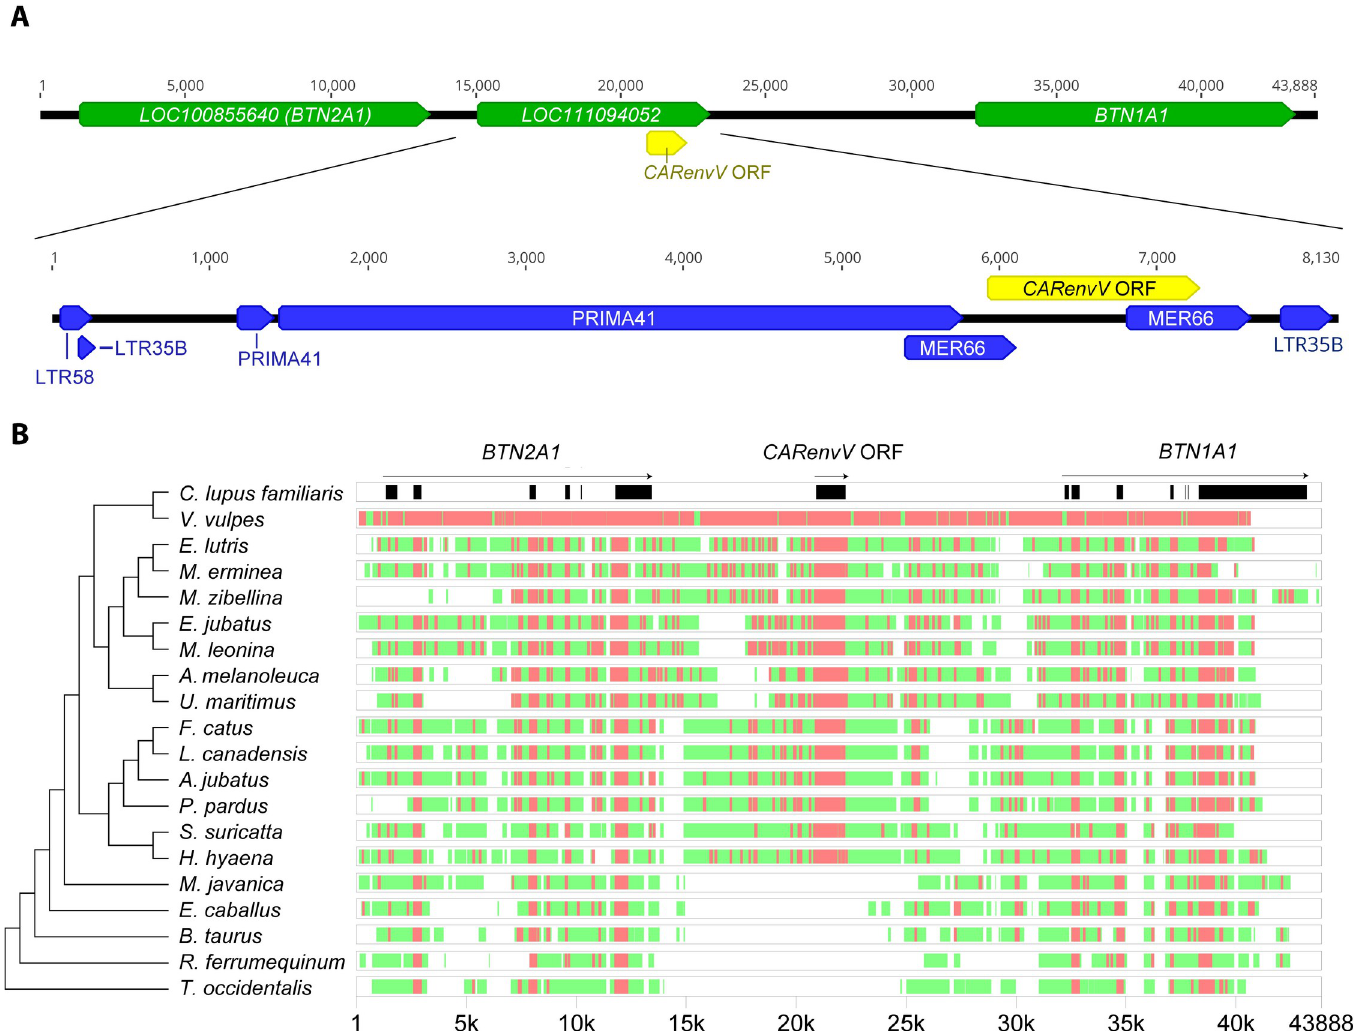
Fig 1. Genomic location and conserved synteny of CARenvV . A. (Upper panel) Chromosomal context of the CARenvV locus is shown for the C . lupus familiaris (domestic dog) genome (ROS_Cfam_1.0, chromosome 35). Refseq annotated genes are shown in green, and the CARenvV ORF is in yellow. (Lower panel) ERV derived repeat elements identified by the Dfam repeat database for the indicated region are annotated in blue. B. Genomic segments containing the CARenvV ORF and the BTN1A1 and BTN2A1 genes were extracted from the NCBI genome database for each of the indicated species and aligned using the MultiPipMaker alignment tool [108]. The CARenvV ORF and the BTN1A1 and BTN2A1 exons are shown in black boxes in the C . lupus familiaris reference assembly. For the other species, regions with more than 75% identity are shown as red boxes while regions with 50–75% identity are shown as green boxes. On the left is a cladogram representing the phylogenetic relationships for the species analyzed that was generated using TimeTree